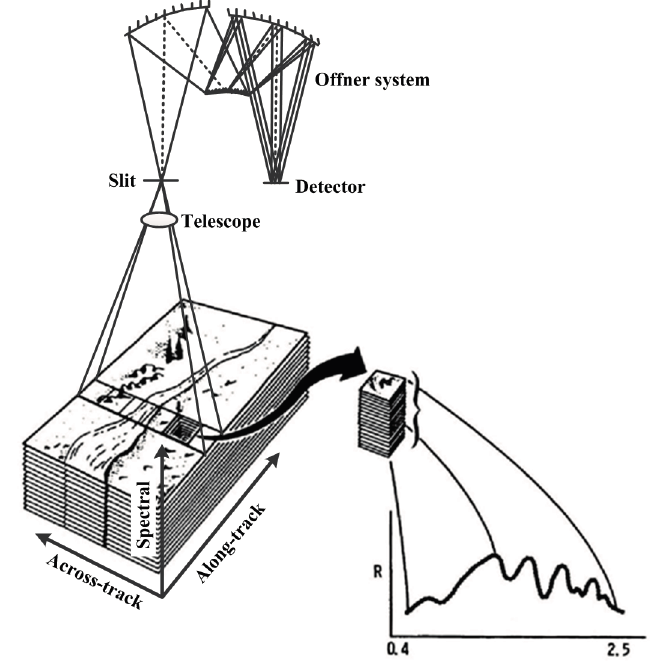
Figure 1. The imaging process of a pushbroom hyperspectral imaging